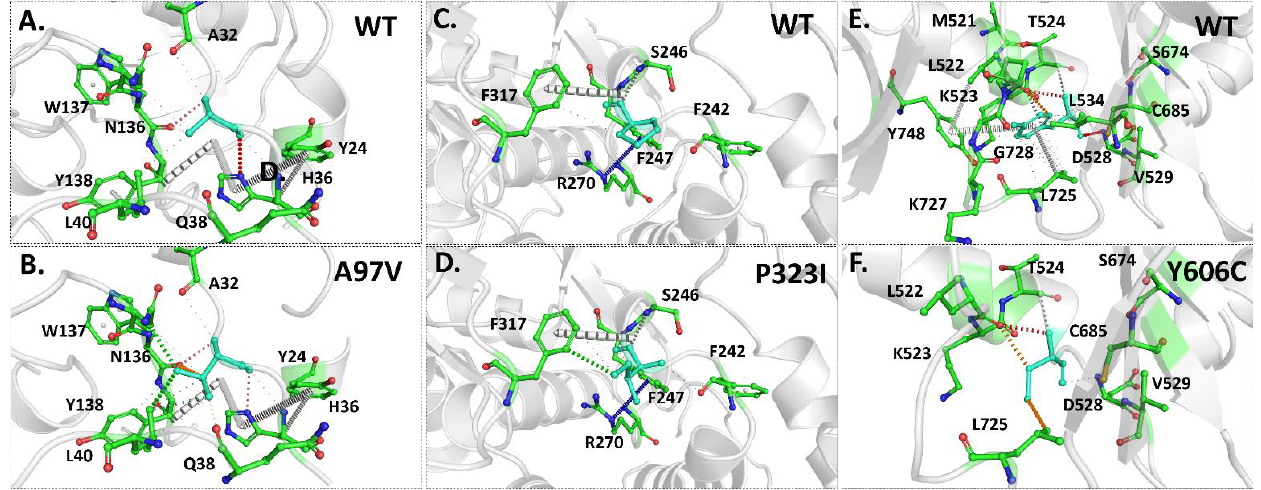
Figure 3. Effect of amino acid substitution on interatomic interactions of RdRp. ( A , B ) show the interatomic interactions mediated by wild type and A97V. ( C , D ) show the interatomic interactions mediated by wild type and P323I. ( E , F ) show the interatomic interactions mediated by wild type and Y606C. Wild-type and mutant residues are colored in cyan and are also represented as sticks alongside the surrounding residues (green), which are involved in any type of interactions.